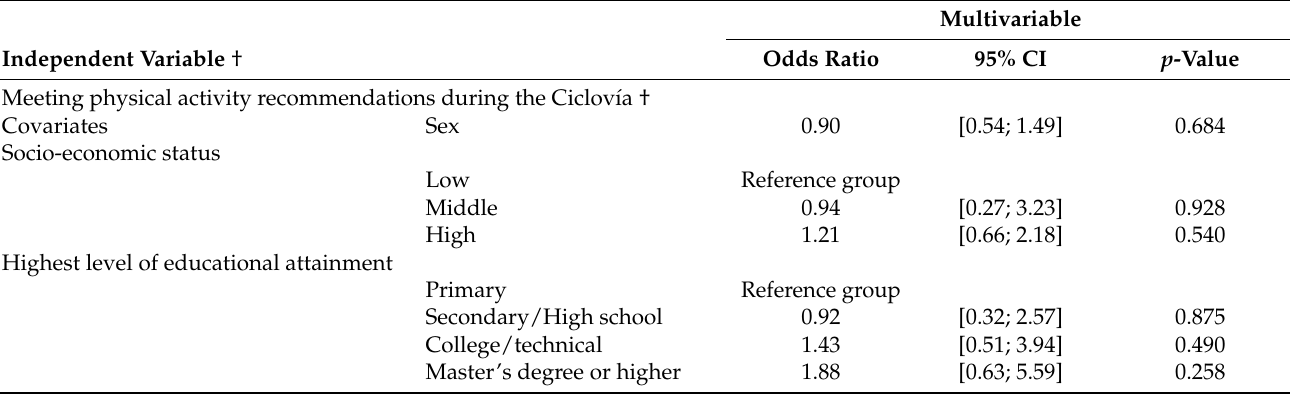
Table 4. Odds ratios of meeting the PA recommendations from WHO associated with participant’s socioeconomic status and the highest level of educational